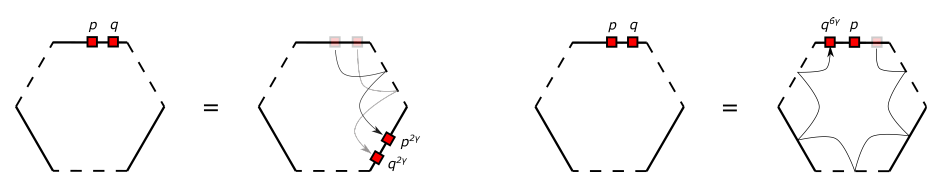
Figure 5 . Consistency conditions for the hexagon construction. Left: cyclically relabeling the edges of the hexagon amount to “move” all excitations by 2 γ in the sense of section 3.3. Right: we can also move one or more individual particles by 6 γ in such a way to obtain a different ordering of momenta, which in turn can be simplified using the Watson equation (see